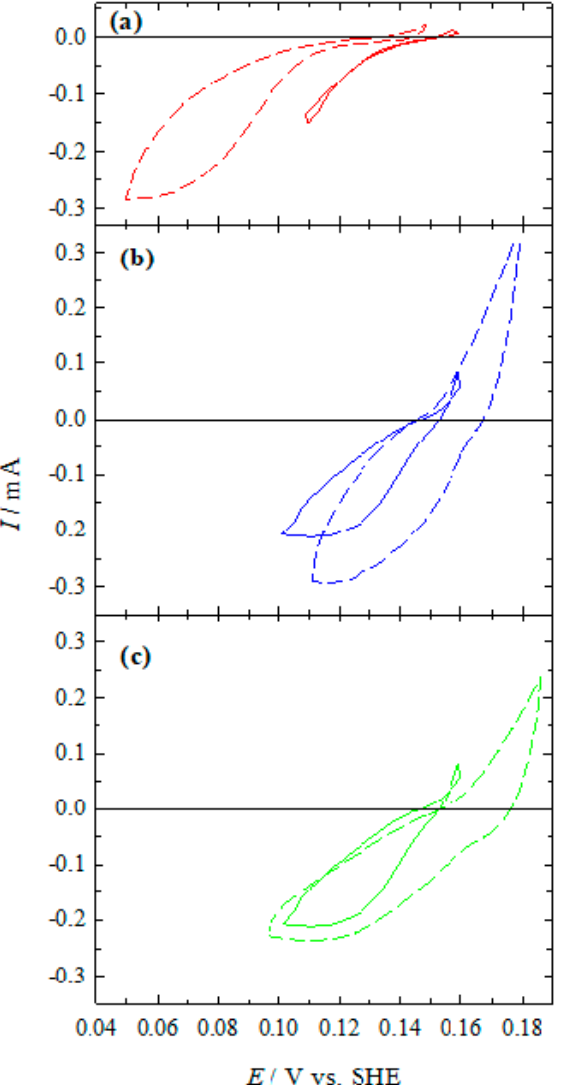
Figure 11. Currents for Ag deposition/dissolution are the same as in Figure 8 (dashed lines) and Figure 10 (solid lines). KCl: 0 ( a ), 10 − 3 ( b ), and 10 − 2 ( c ); pH 10.9; 20 °C. Potential sweep rate 2 mV s − 1